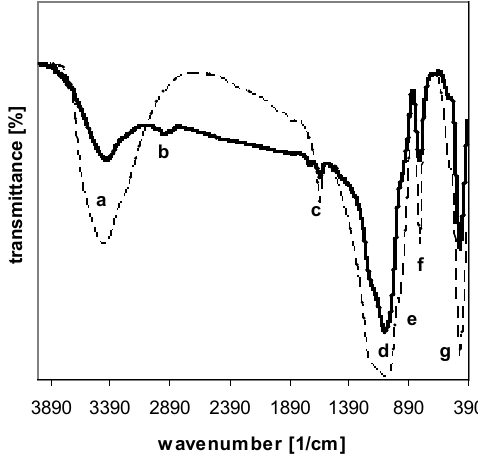
Figure 1. FTIR spectrum of the silica coated carbon nanomaterial (__ __ ) and the support 1 (______ ), where peaks were assigned: a O-H stretching; b C-H stretching; c angular vibrations of the water molecule; d siloxane vibrations; e silanol deformation; f Si-O-Si stretching; g Si-O-Si